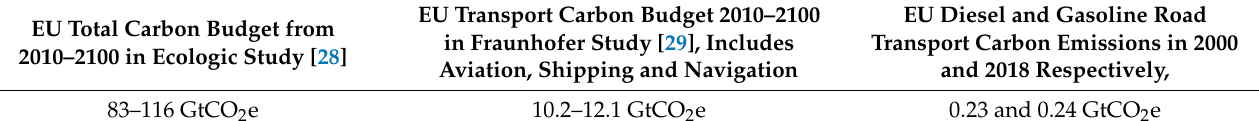
Table 2. BAU road transport emissions and the EU carbon budget for 1.5 ◦ C and 2 ◦ C scenario. EU Total Carbon Budget